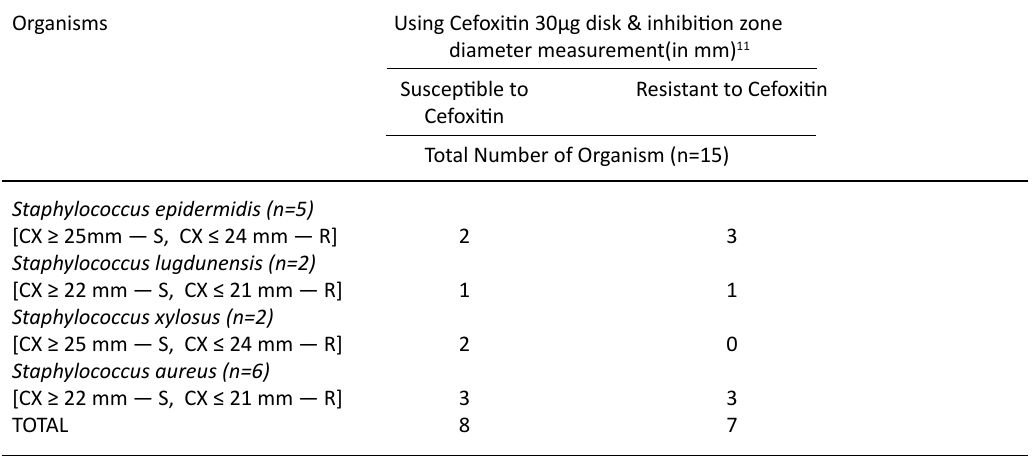
Table 1. Number of Methicillin Sensitive / Resistant isolates among different Staphylococcus species Organisms Using Cefoxitin 30µg disk & inhibition zone diameter measurement(in mm)